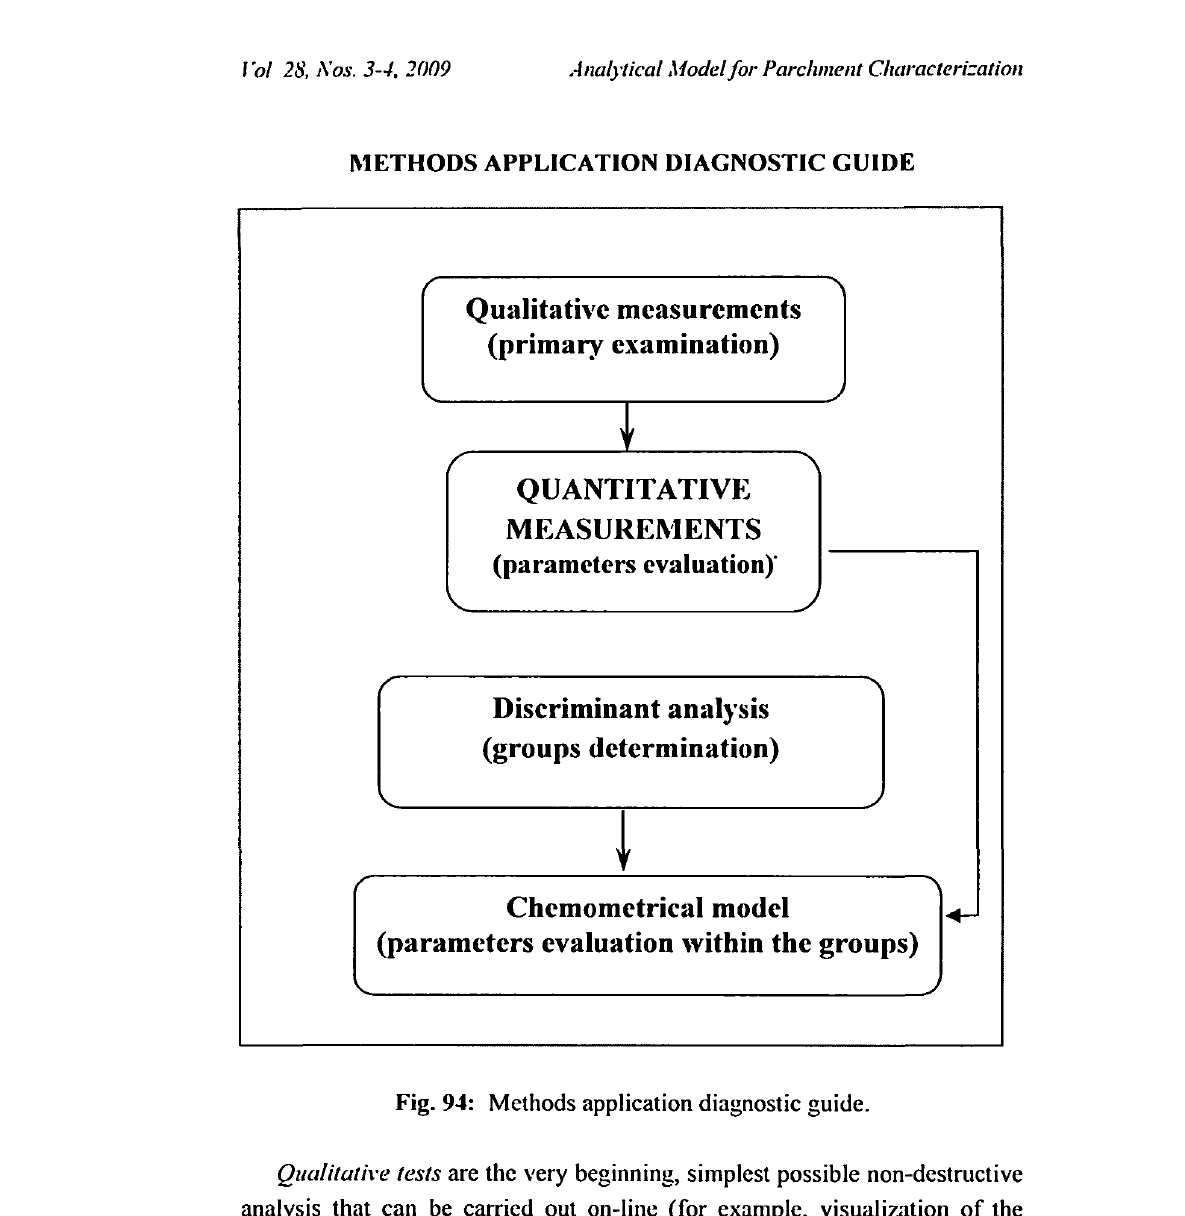
Fig. 94: Methods application diagnostic